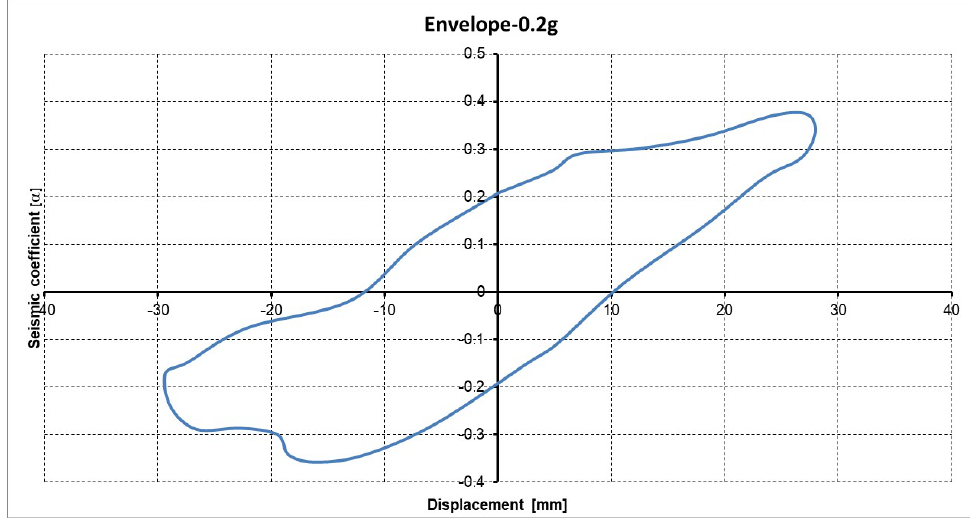
Figure 13. Envelope of the hysteresis curve in the transversal direction.